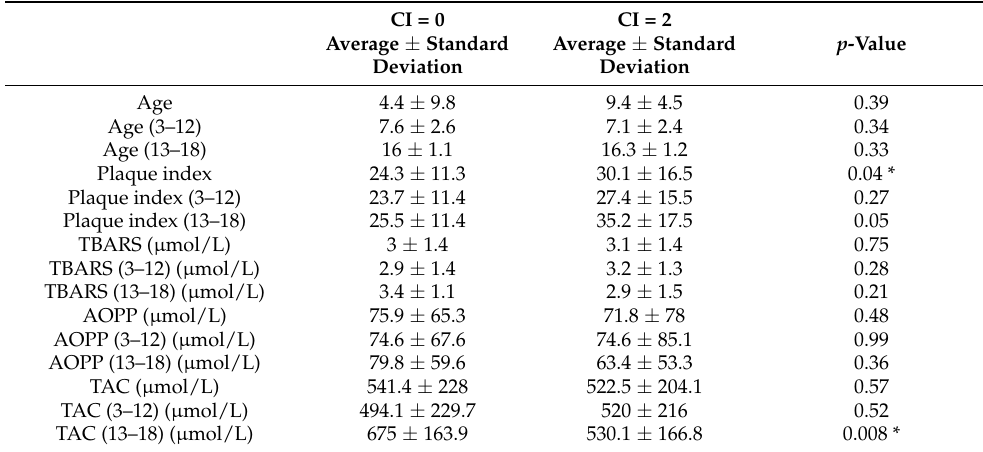
Table 2. Individual relation of CI with oxidative stress markers, age and plaque index.